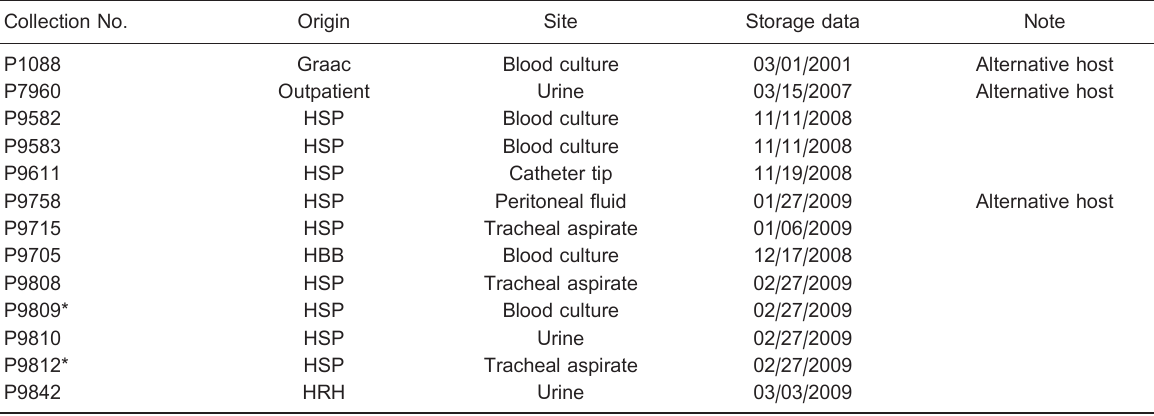
Table 1. Clinical isolates of Pseudomonas aeruginosa included in this study. Collection